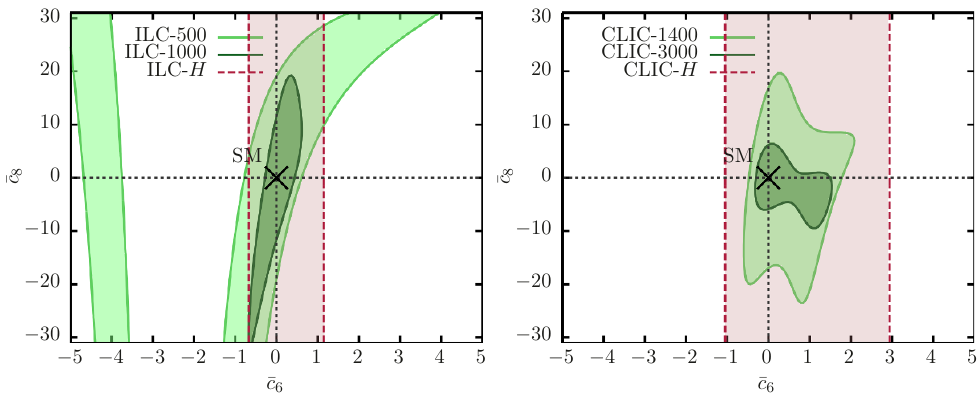
Figure 15 . Combined 2 (cid:27) constraints in the ((cid:22) c 6 ; (cid:22) c 8 ) assuming SM cross sections, at the ILC (left) and CLIC (right), in the Scenario 2 described in the text. ILC- H and CLIC- H refer to a combination of all single Higgs measurements at all energy stages for each collider under